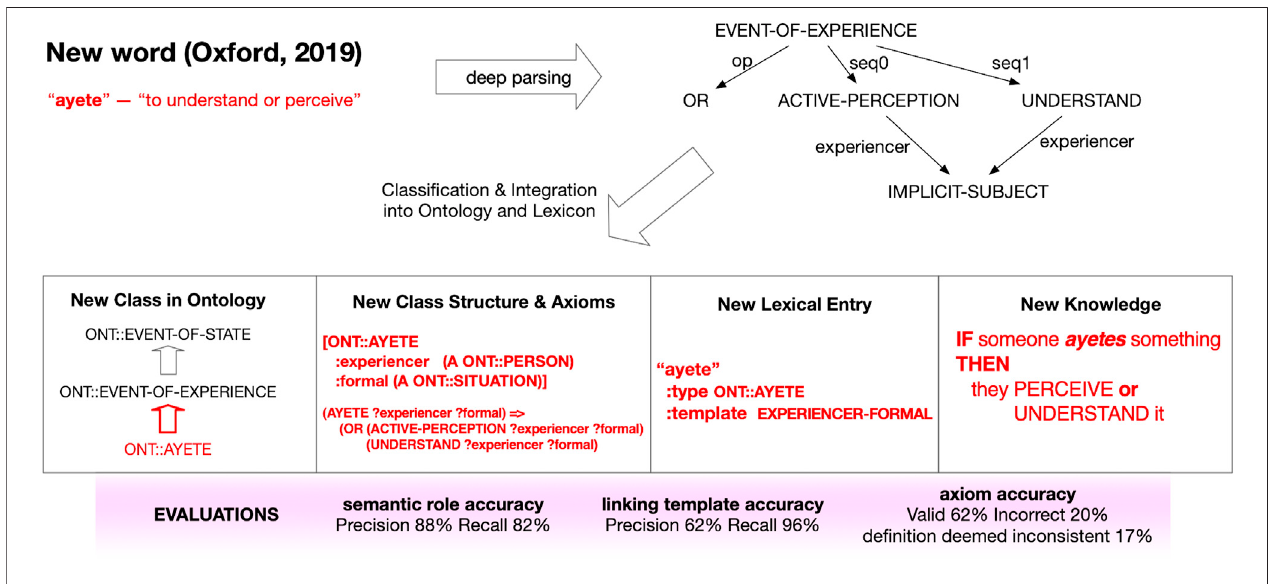
FIGURE6| Buildingnewconceptsfromknownconcepts:WhentheTRIPSsystemencountersanunknownword,itisabletolookthewordupinadictionary,and basedonthede fi nition,itextendsitsontologywithanewconcept,includingaxiomsthatrelatethenewconcepttoexistingconceptsandbuildlexicalentriesfortheword that enables sentences including the new word to be understood. The fi gure shows how the word “ ayete ” , listed as a new word in the Oxford dictionary in 2019, is processed, adding the new understanding that represents the new word “ ayete ” in terms of known concepts “ perceive ” and “ understand ” . This demonstrates Hallmark EC-3. The image was provided by IHMC (James Allen, email to the authors, February 5, 2021) to illustrate how this capability works.